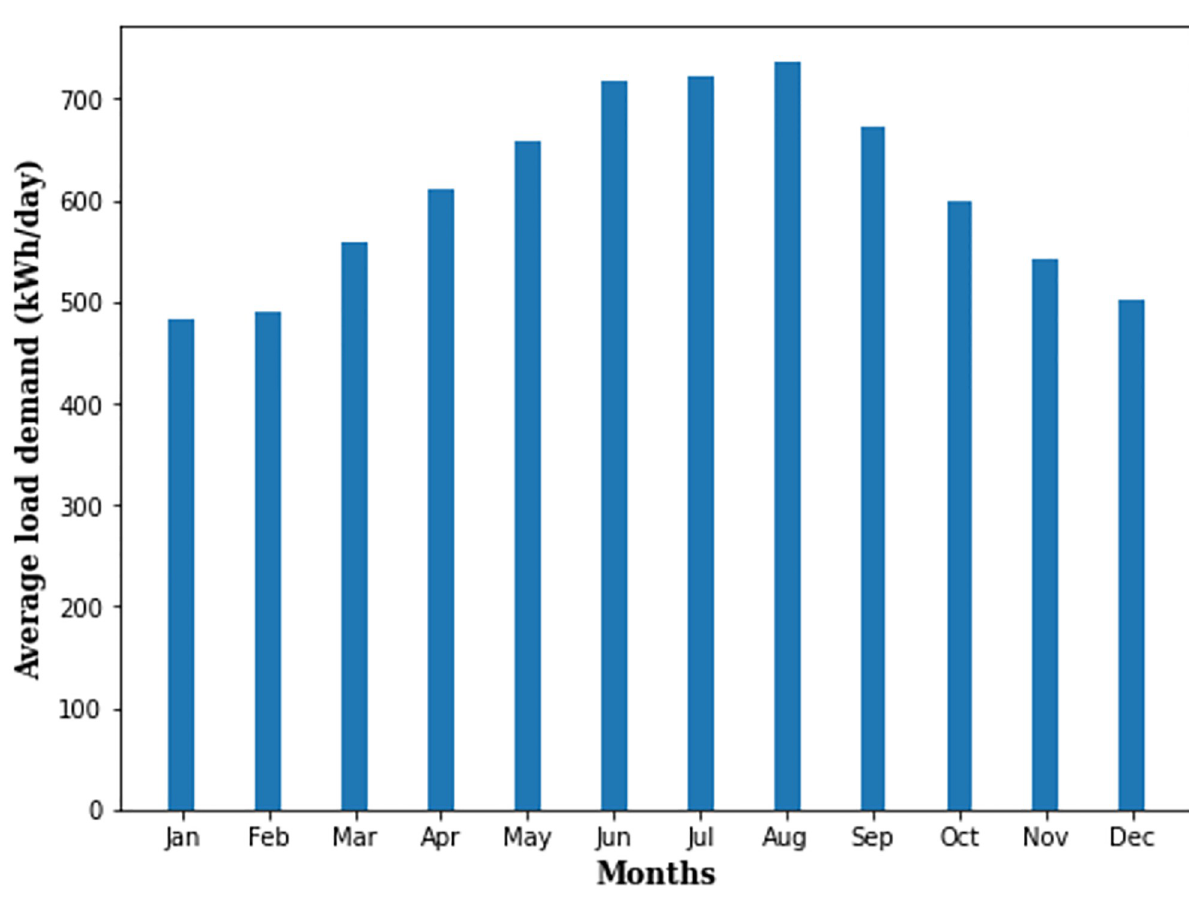
Fig 1. The community load